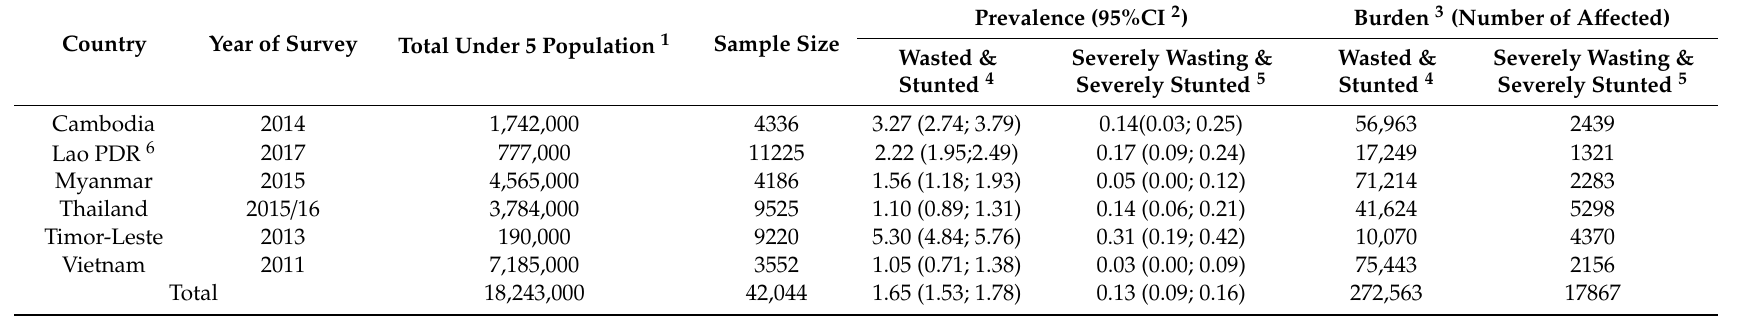
Table 3. Prevalence and burden of wasting and stunting